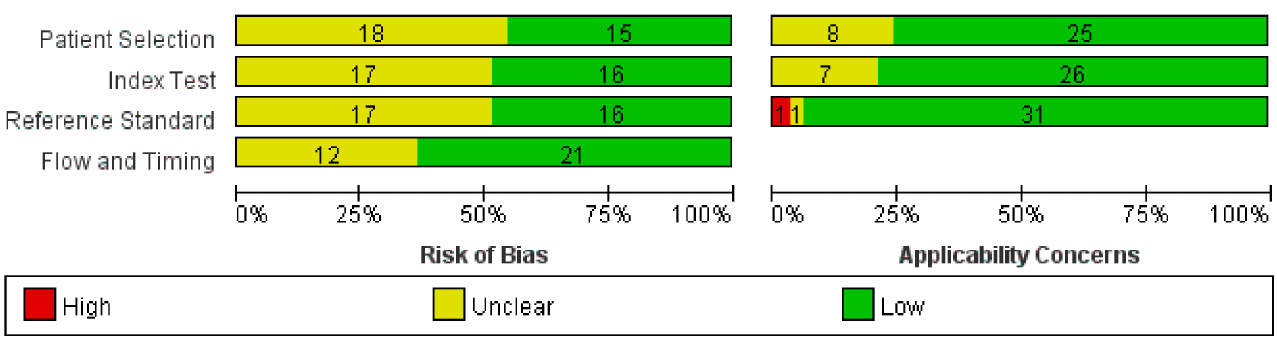
Figure 2. Risk of bias and applicability concerns.